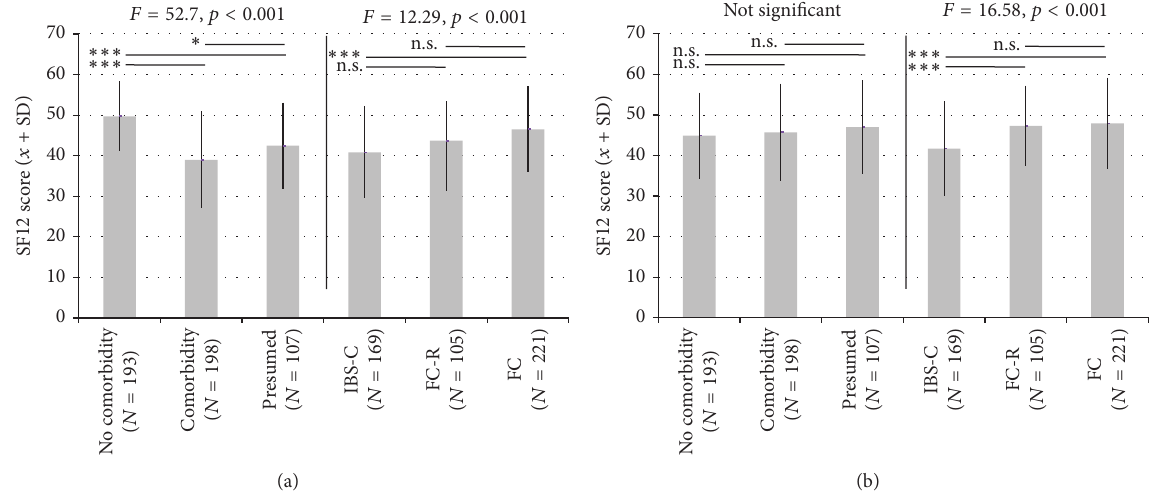
Figure 2: SF-12 quality-of-life measure in individuals with constipation. (a) In the SF12 physical domain; left panel: individuals with acknowledged or with presumed somatic comorbidity or without comorbidity; right panel: in individuals matching IBS-C, FC-R, and FC criteria (see text for details). (b) In the mental domain. In each panel, 𝐹 -values indicate significance in the between-group ANOVA; “ ∗ ” indicates significance in post hoc 𝑡 -tests (uncorrected): ∗∗∗ 𝑝 < 0.001 and ∗ 𝑝 < 0.05 .